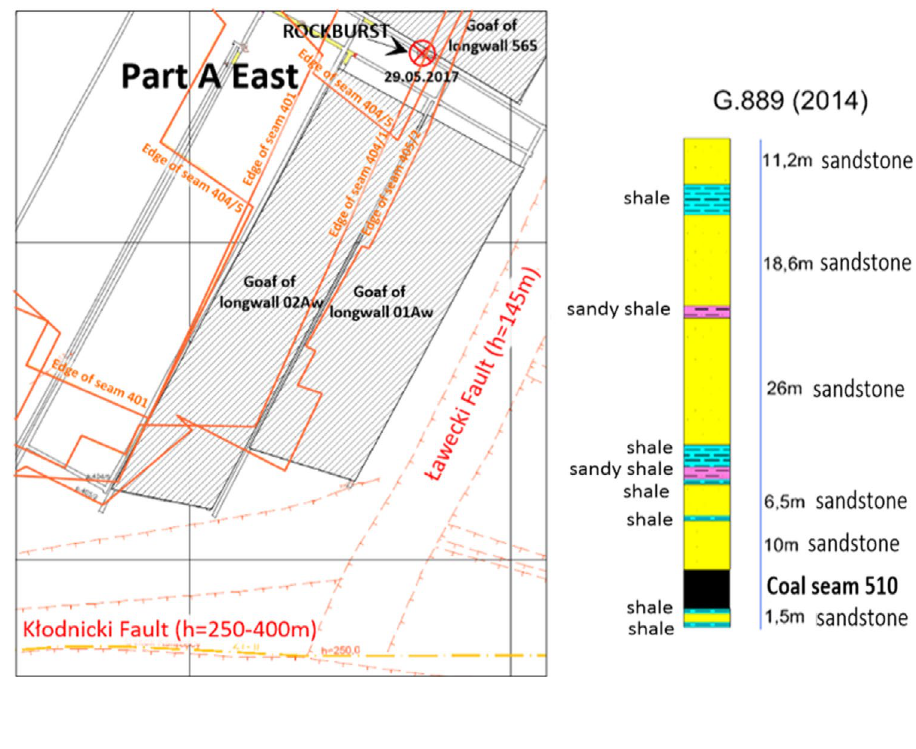
Table 5 Characteristics of seismicity occurring in the area of the longwall 02Aw panel